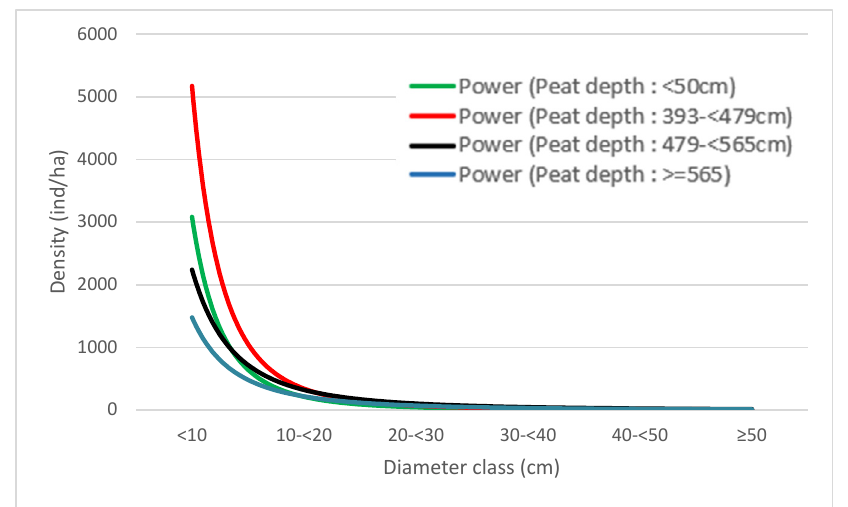
Fig. 8: Diameter distributions of stands at the peat depths of <50 cm, 393‐<479 cm, 479‐<565 cm, and ≥565 cm